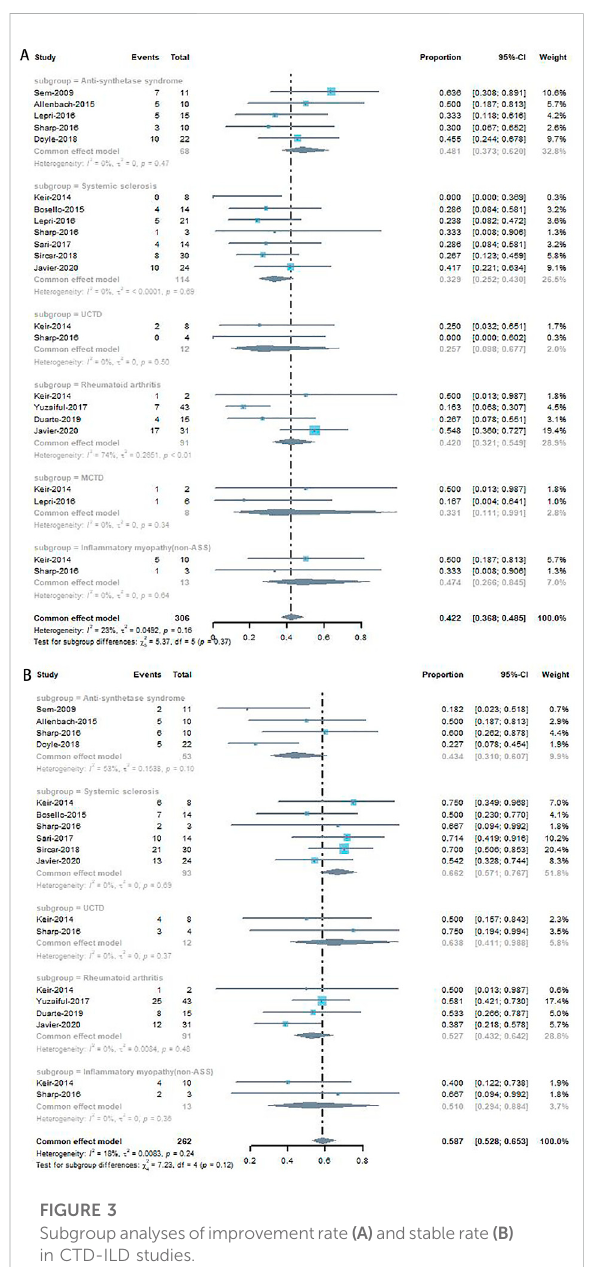
FIGURE 3 Subgroupanalysesofimprovementrate (A) andstablerate (B) in CTD-ILD